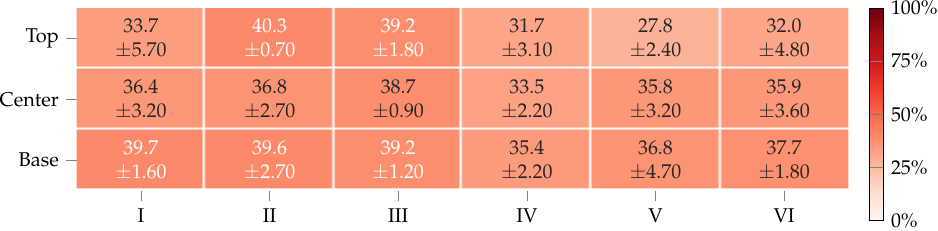
Figure 8. Average FVC and standard deviations of three different samples molded with process Configuration A are analyzed via thermal gravimetric analysis. The partitioning follows the illustration in Figure 1b, where the red dotted lines indicate the separation between top, center and base of the coupons.